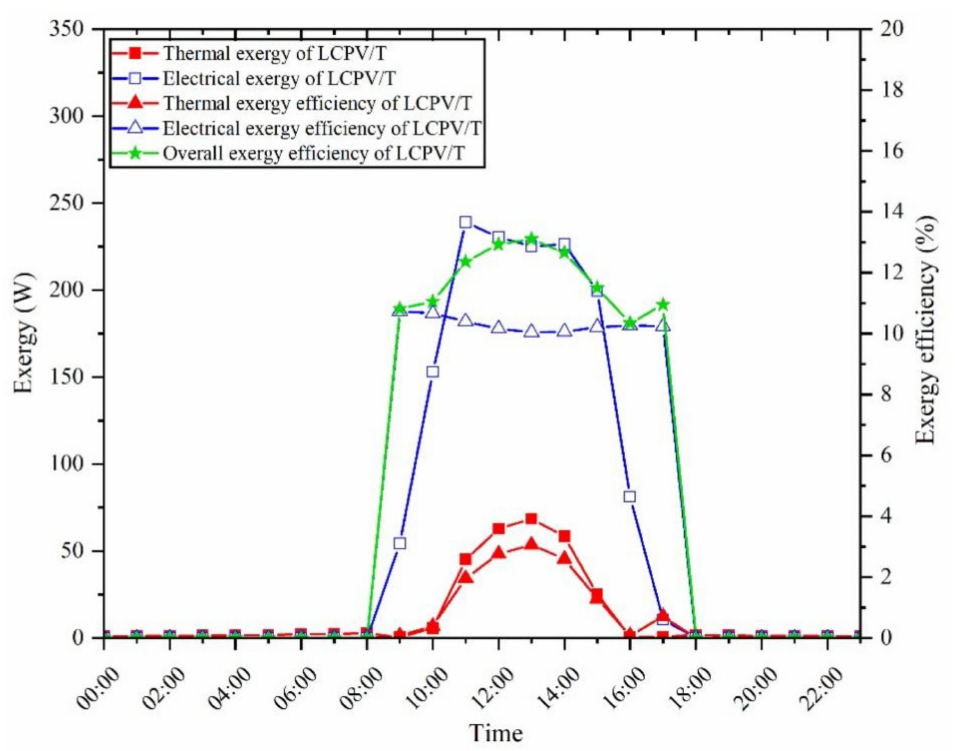
Figure 7. Exergy performance of LCPV/T on 15